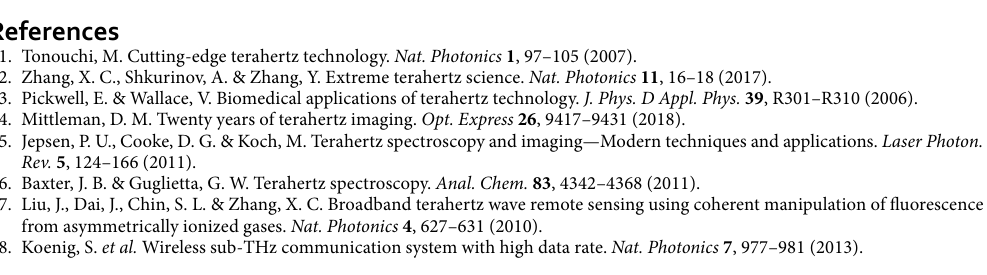
Figure 7. ( a ) 3D isosurface of beat-frequency THz radiation field (in red-color) at t (cut through x -, y -, and z -axis) of the THz radiation field. ( e ) Comparison of THz field strength (measured on the front-side of the target) through 2D and 3D PIC simulations for the same set of parameters. ( f ) Snapshot of X–Y spatial distribution of THz radiation field from 2D